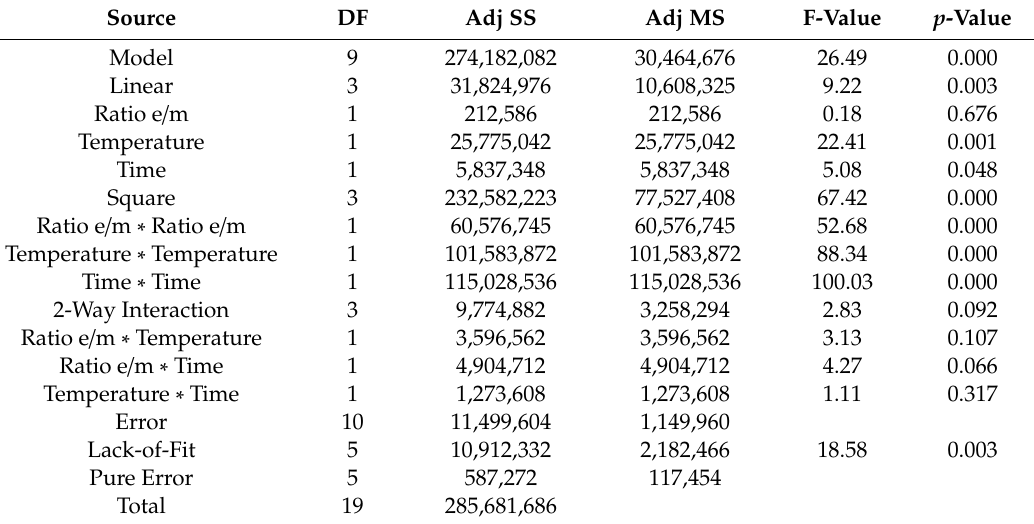
Table 3. Analysis of variance for total antioxidant capacity (TAC).